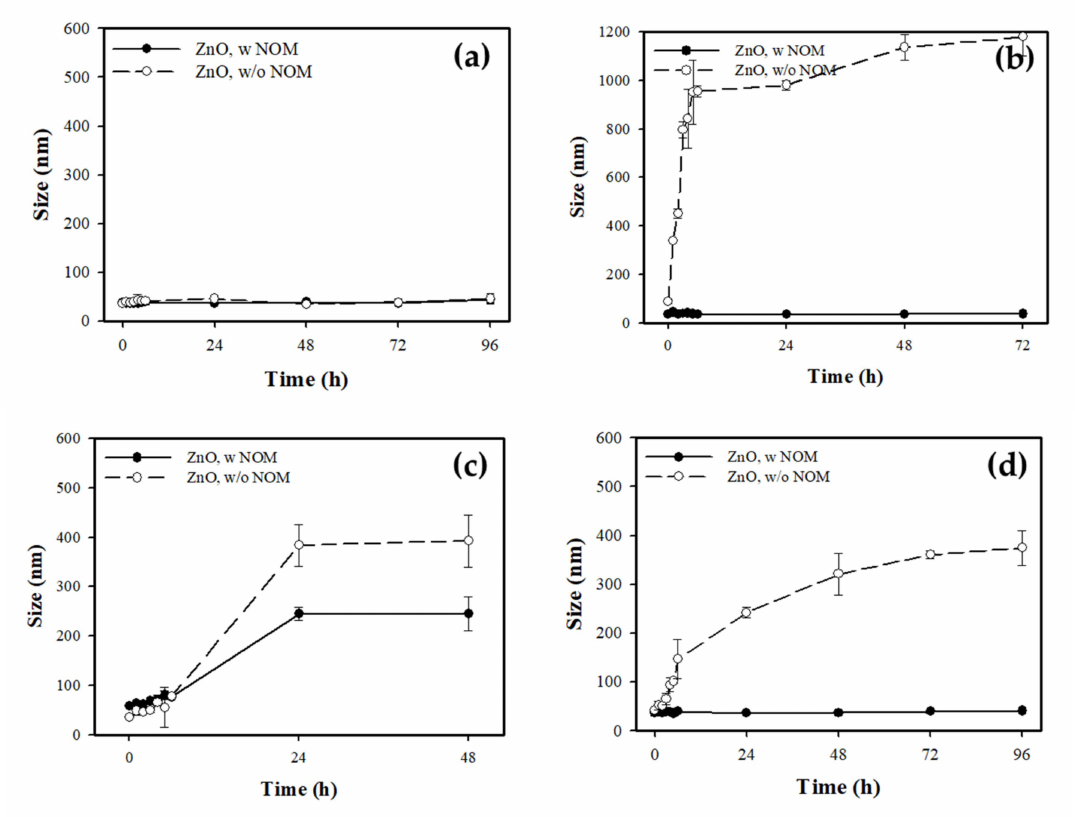
Figure 5. Hydrodynamic diameter of ZnO NPs with / without NOM in DI water ( a ), OECD medium ( b ), ISO medium ( c ), and dechlorinated tap water ( d